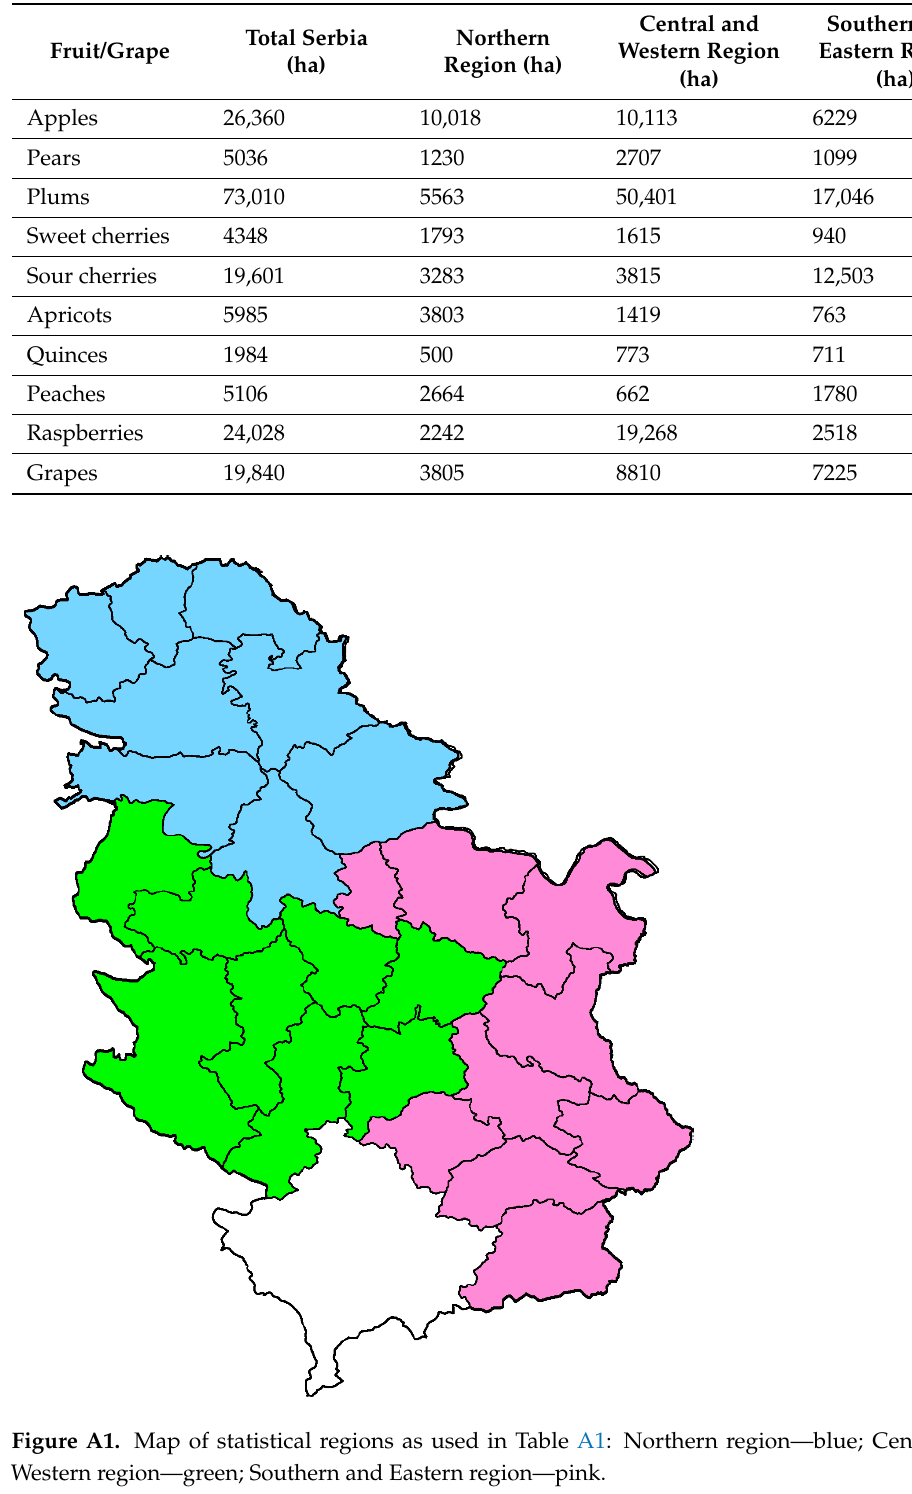
Table A2. Definition of viticultural indices and corresponding climate categories for the northern hemisphere.